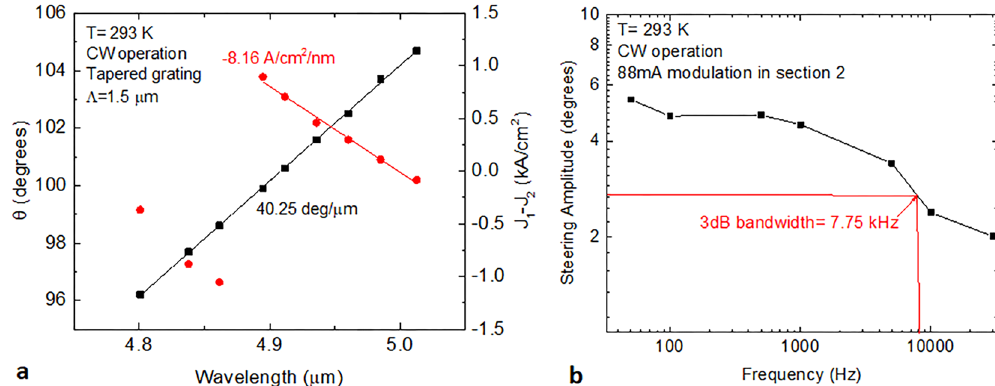
Figure 6. Tuning, steering, and modulation characteristics for SGDFB lasers with tapered grating outcouplers. ( a ) Steering angle and relative current density in the SGDFB sections as a function of emission wavelength. ( b ) Measured steering angle amplitude as a function of modulation frequency. Lines connecting data are a guide for the eye.